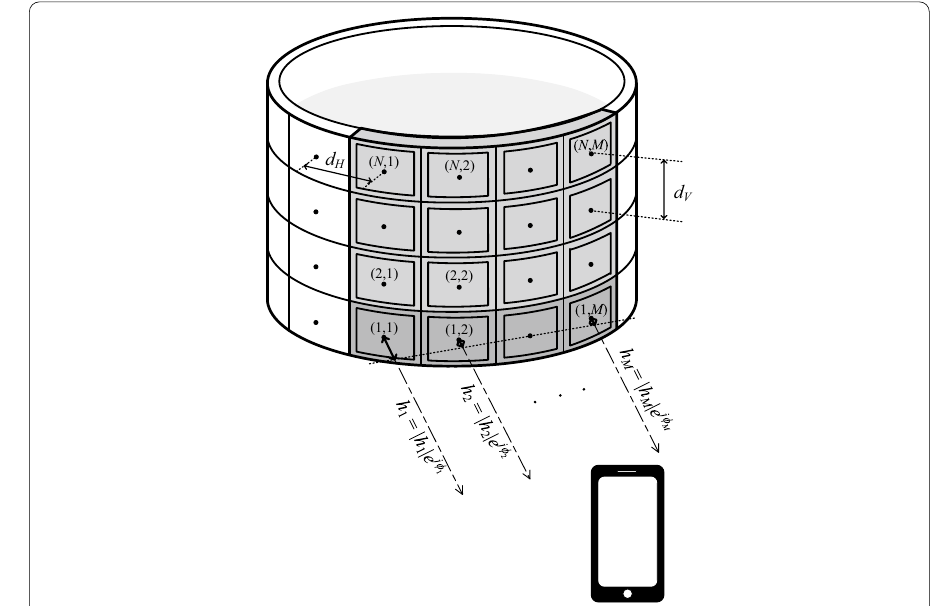
Fig. 2 M antennas on a curvature for transmission to the target